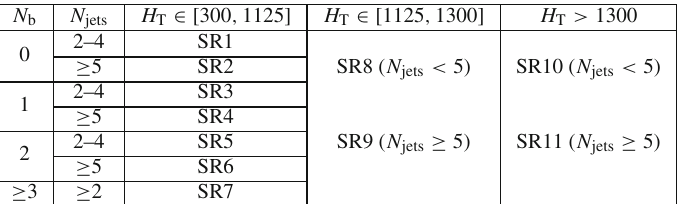
Table 5 The SR definitions for the LM category. All SRs in this category require p miss are split only by N jets , resulting in 11 regions in total. Quantities are specified in units of GeV where applicable.